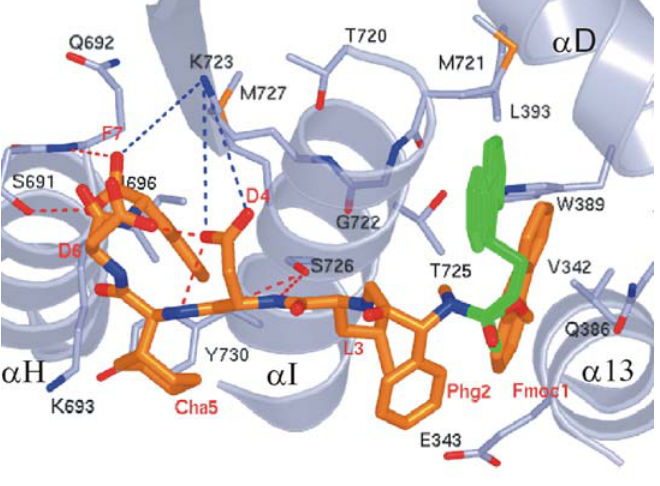
Figure 9. P6 binding to ScRR1. P6-orange, The figure was reproduced with permission from Xu et al. , [97]. Copyright (2008) American Chemical